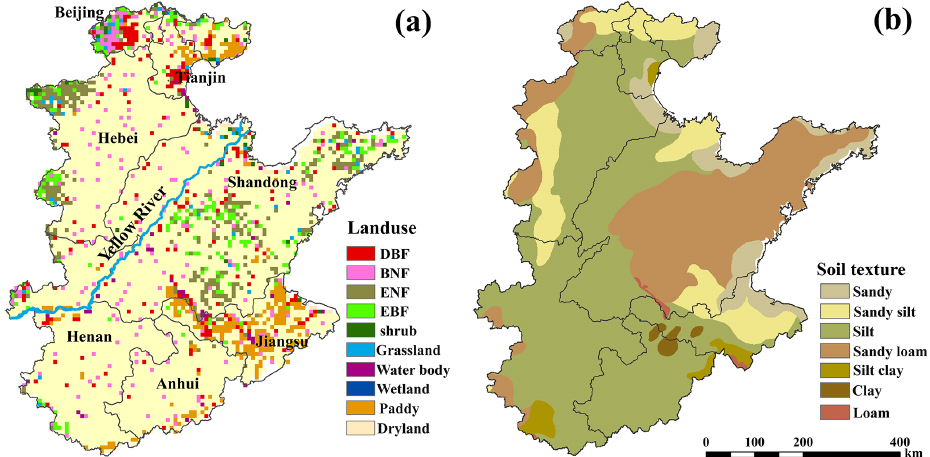
Figure 1. Land use/cover (a) and soil texture (b) of the North China Plain (NCP) (DBF: deciduous broadleaf forest; BNF: broadleaf and needleleaf mixed forest; ENF: evergreen needleleaf forest; EBF: evergreen broadleaf